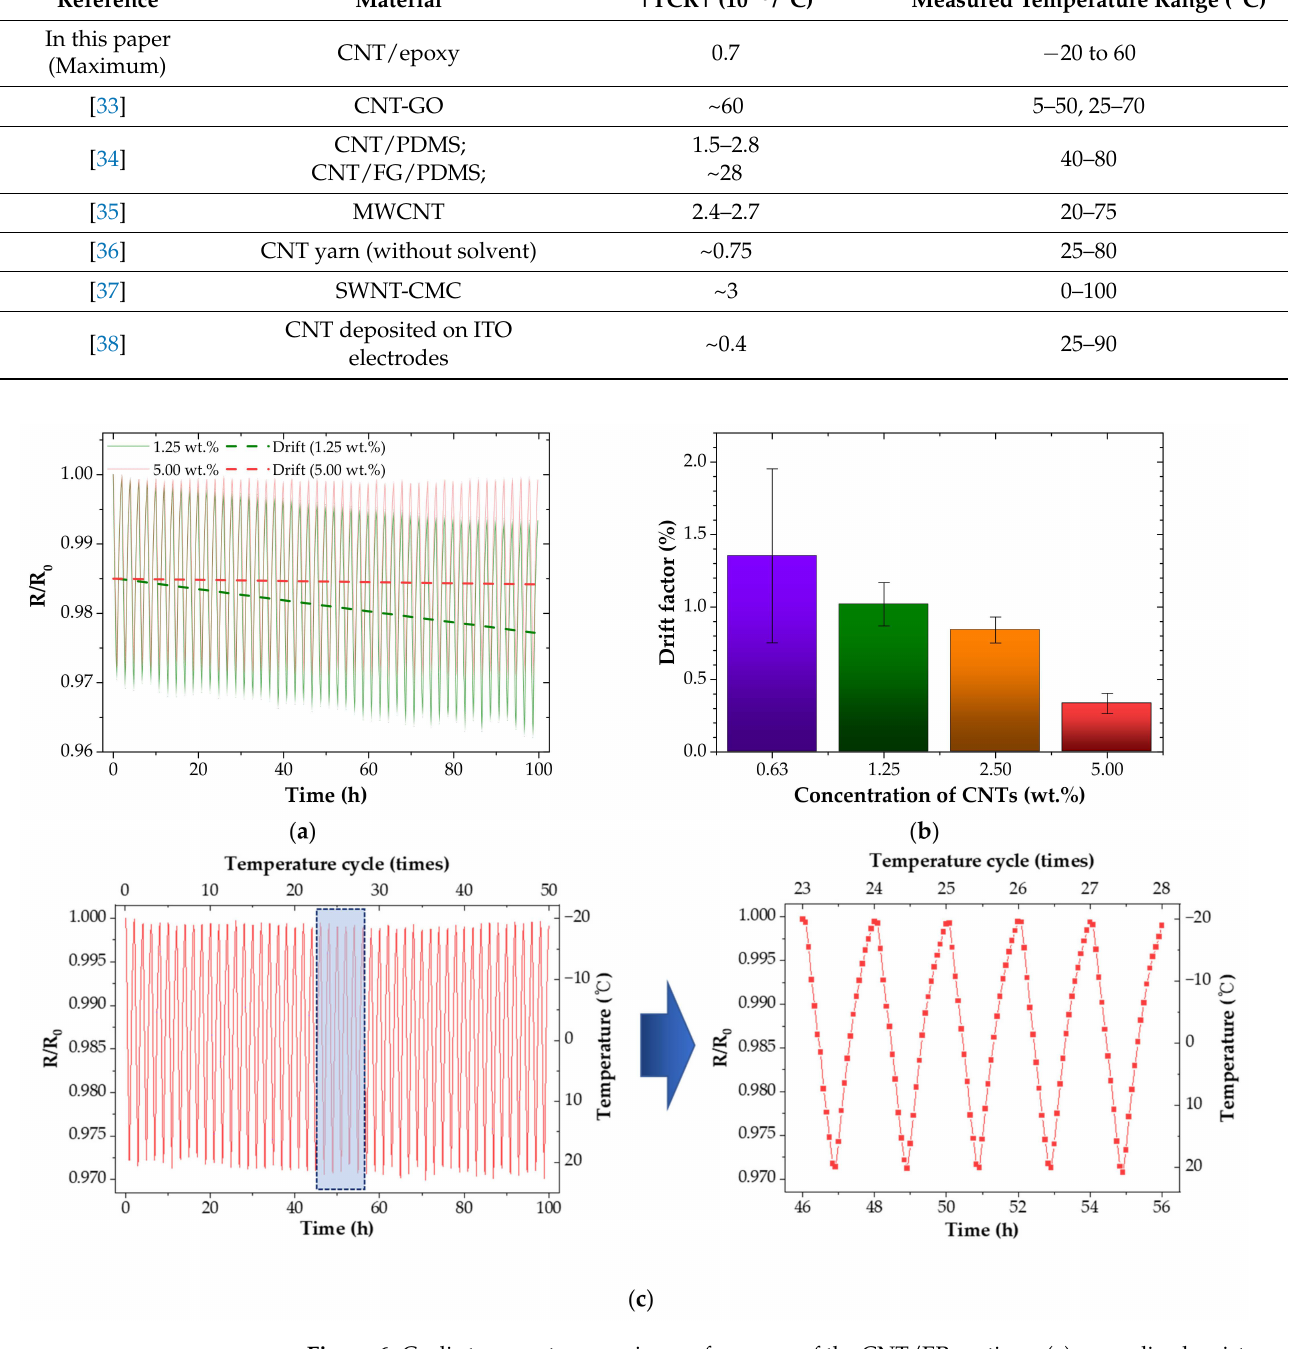
Figure 6. Cyclic temperature sensing performance of the CNT/EP coatings; ( a ) normalized resistance (1.25 wt.%, 5.00 wt.%); ( b ) drift factor; ( c ) sensing performance (5.00